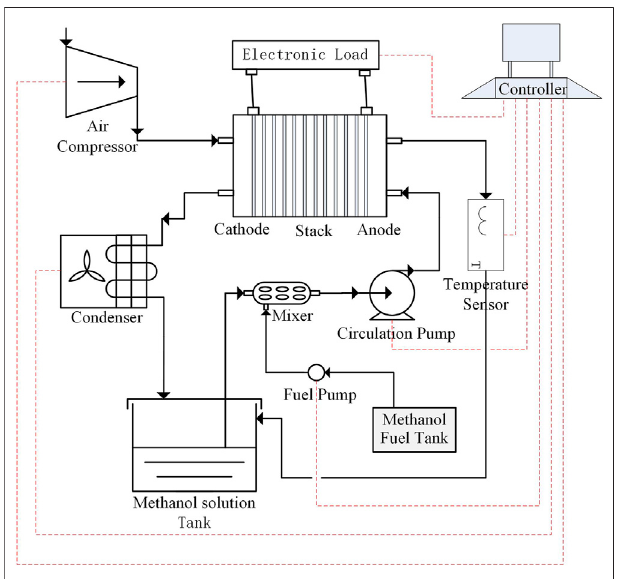
FIGURE 1 | Con fi guration of the DMFC test